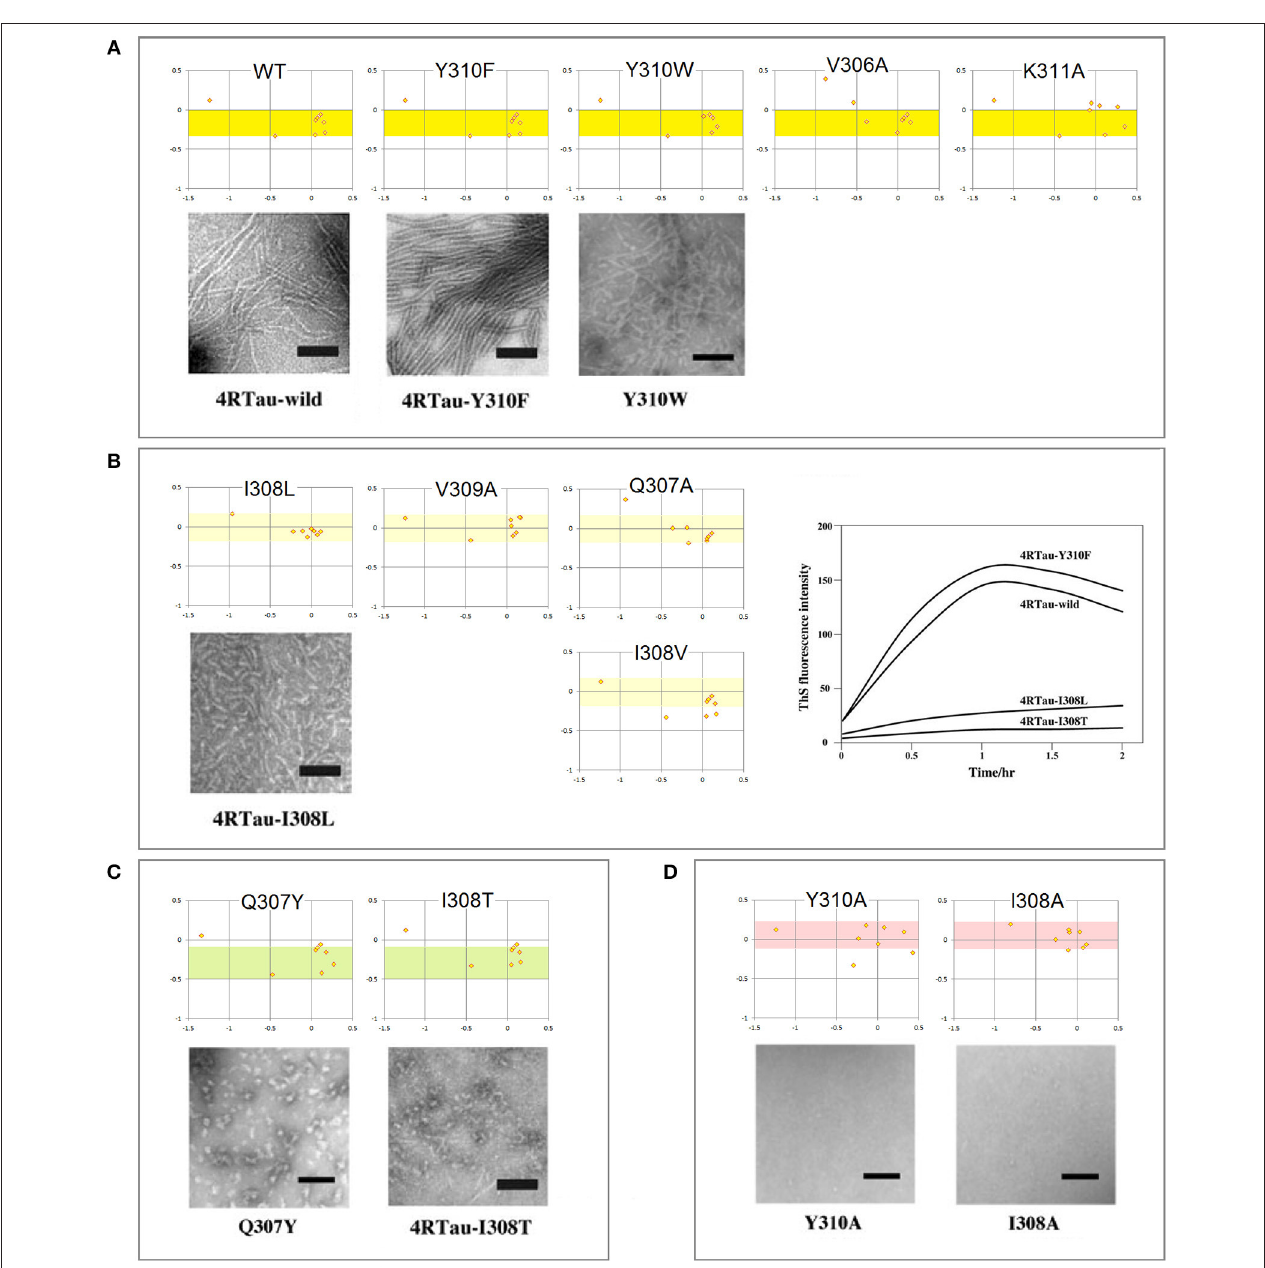
FIGURE 6 | Electronic configuration of the polypeptide backbone and aggregation properties of single-site mutants of tau PHF6: the FP i vs. 1 FP i − 1 → i + 1 plots and EM morphology. The results obtained by the heparin-induced fibrillization experiments conducted in Tris-HCl buffer at pH 7.6: (A) Mutants forming wild-type filaments. All the mutants retain the “C 5 strand” propensity of wt PHF6 (the yellow-color coded region of FP i ). (B) Mutants forming short filaments. The “C 5 strand” propensity of PHF6 tends to be attenuated compared to the wild type (the pale yellow-color coded region of FP i ); the plot on the right-hand side illustrates the effect of mutations on the intensity of thioflavin S fluorescence. (C) Mutants forming granules. The “C 5 strand” propensity of PHF6 tends to be increased compared to the wild type (the green-color coded region of FP i ). (D) Mutants forming neither granules nor filaments. The “C 5 strand” propensity of wt PHF6 is lost, replaced by the “helix” propensity (the red-color coded region of FP i ). The inserted images are taken from the articles cited in the